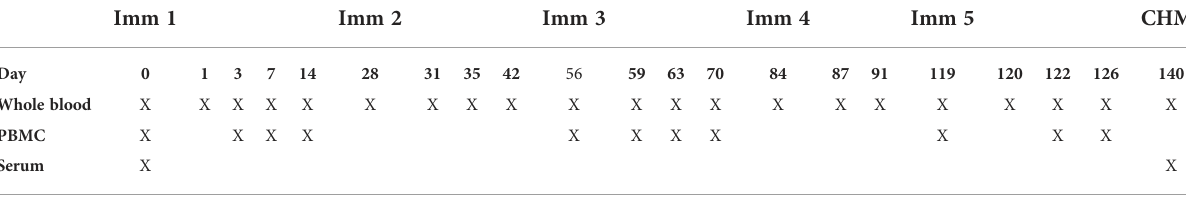
TABLE 1 IMRAS sampling schedule. X indicates where speci fi c sample types were